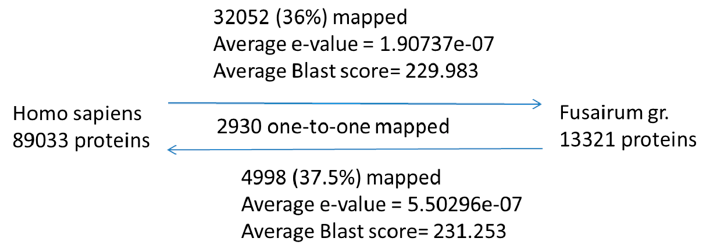
Figure 3. Statistical information regarding the mapping of human proteins to the Fusarium graminearum proteome. Sequence similarity was determined using in-house methodology.